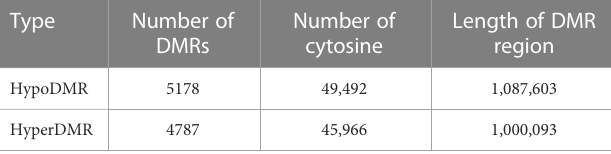
negatively related to AJAP1 , as shown in Supplementary table S3.